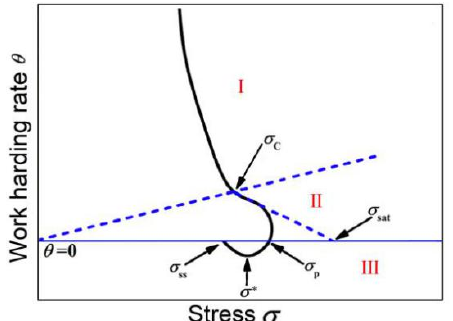
Figure 9. Schematic of the relation between working-hardening rate and flow stress.